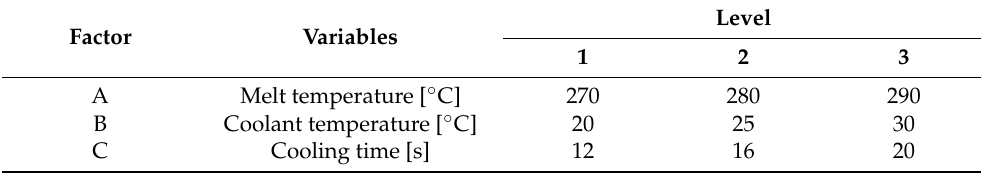
Table 9. Design variables and levels for open lever.